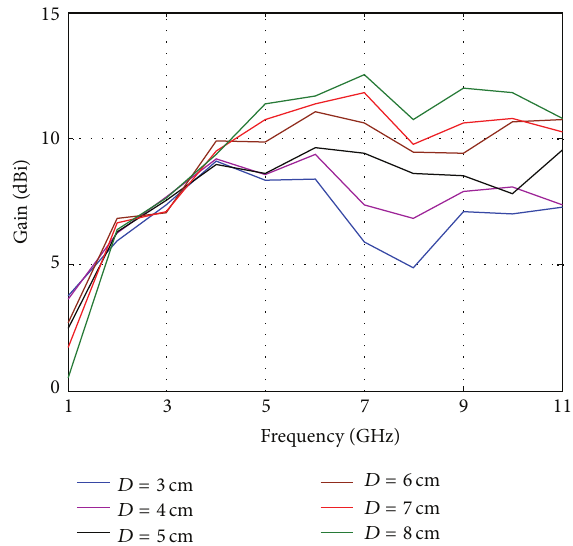
Figure 2: The variation of gain with respect to frequency for various aperture depth ( 𝐷 ) values (simulation